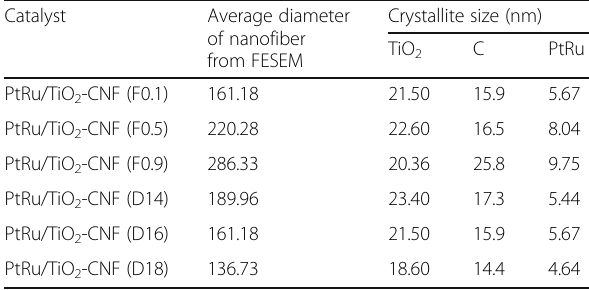
Table 4 Diameter of nanofiber from FESEM and crystallite size of particle in catalyst from XRD data Catalyst Average diameter Crystallite size (nm) of nanofiber TiO 2 from FESEM